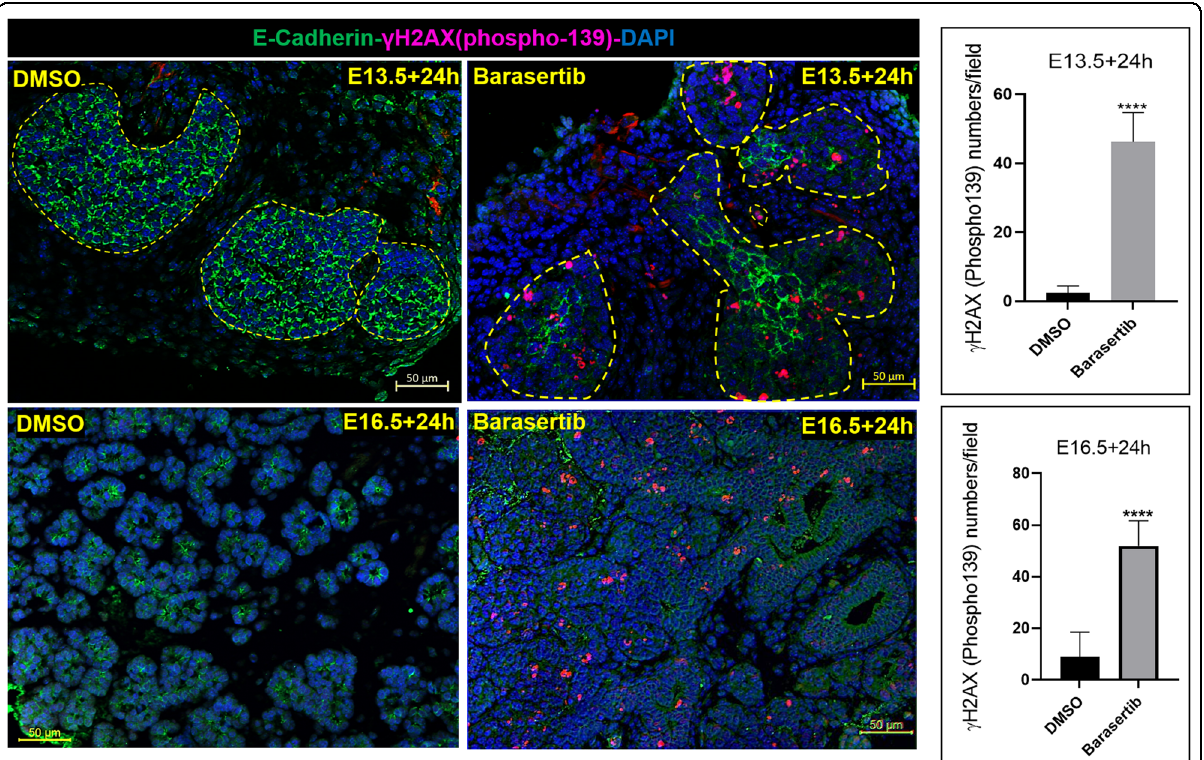
Fig. 6 AURKB inhibition triggered double-strand breaks (DSBs): Abundant expression of phospho- γ H2AX (magenta), a marker of double- strand DNA breaks, in the developing buds following AURKB blockade for 24 h. Cell counting revealed extremely signi fi cant increase in the number of bud cells exposed to double-strand breaks after AURKB inhibition, analysed by paired Student ’ s t test at E13.5 + 24 h and E16.5 + 24 h (**** P ≤ 0.0001, number of glands analysed ≥ 3, number of fi elds/group = 7 – 13), scale bar = 50